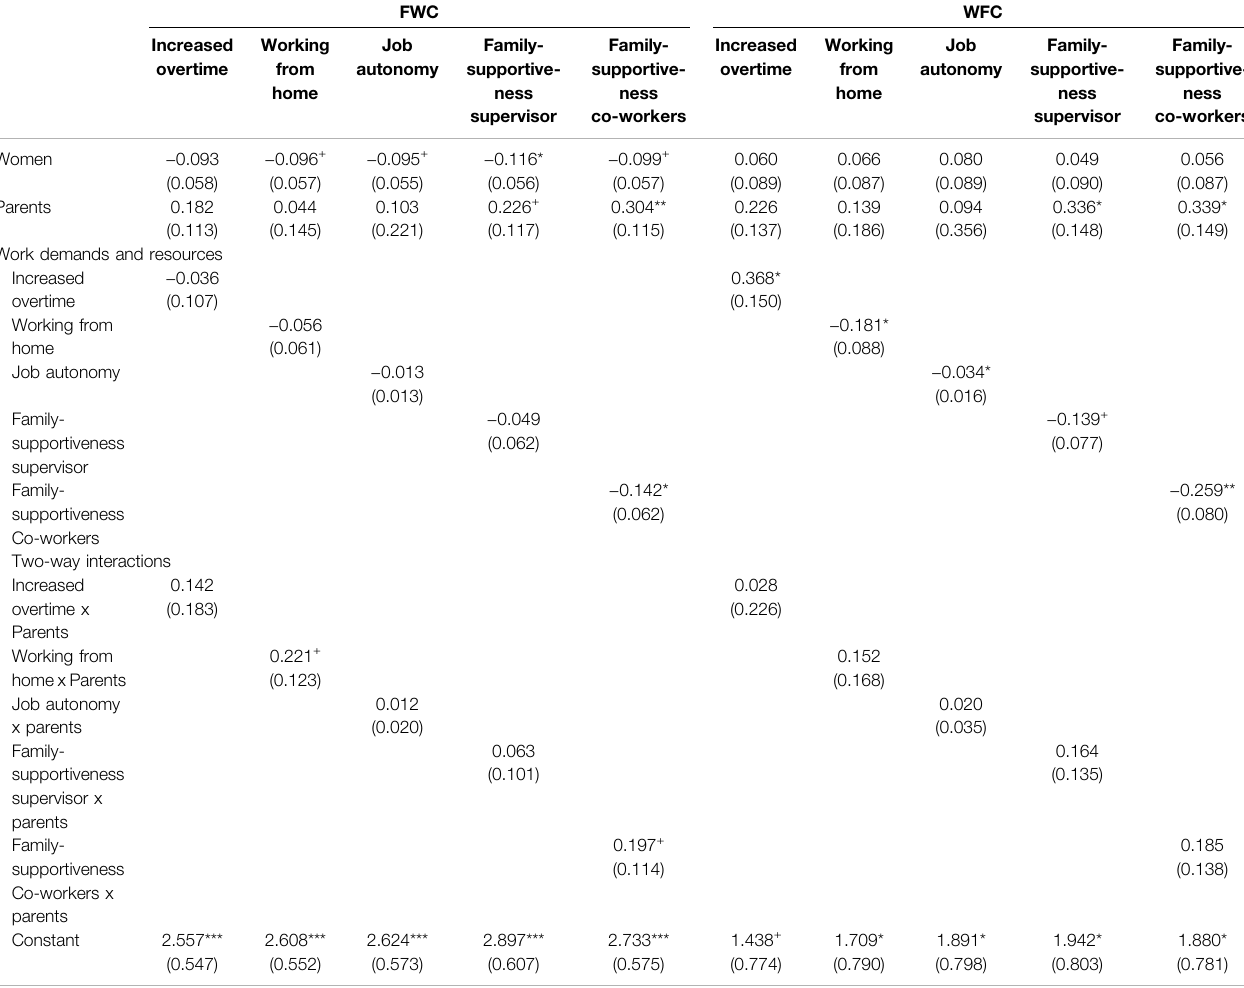
TABLE 7 | Linear regressions on employees ’ FWC and WFC accounting for work resources and demands ( N (cid:1)